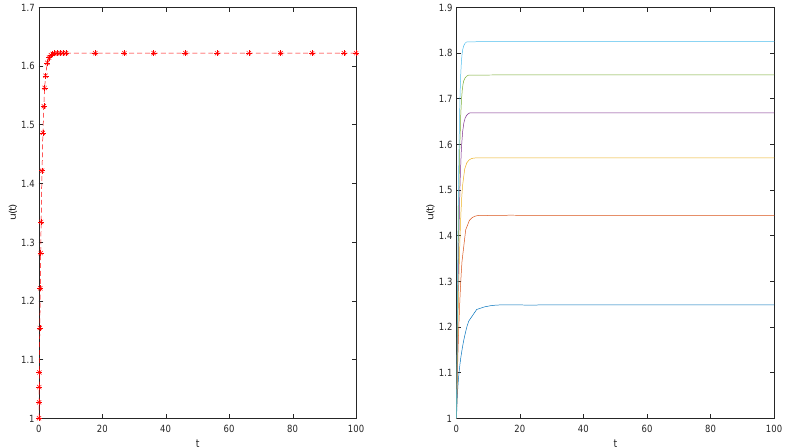
Figure 1. On the left: the bounded solution u ( t ) when εβ = 3.6, u 0 = 1, C 1 = − 0.2, C 2 = 0.2. On the right: the bounded functions u ( t ) as − 0.6 ≤ C 1 ≤